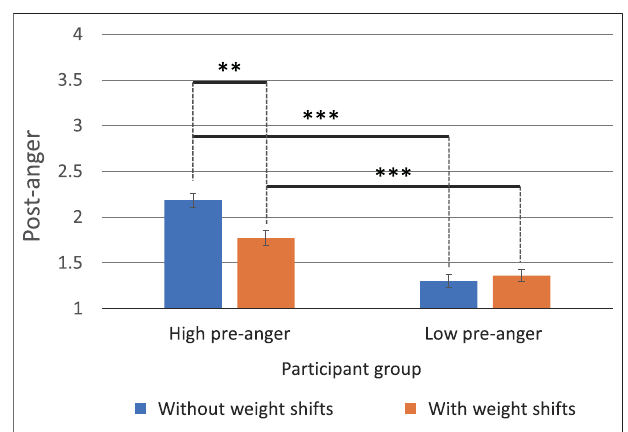
FIGURE 4 | Post-anger comparison (marginal means). In the high pre- anger participant group, participants ’ post-anger was signi fi cantly smaller undertheconditiontherobotexhibitedweightshiftscomparedwiththecaseit exhibited no weight shift (** p < 0.01, *** p <